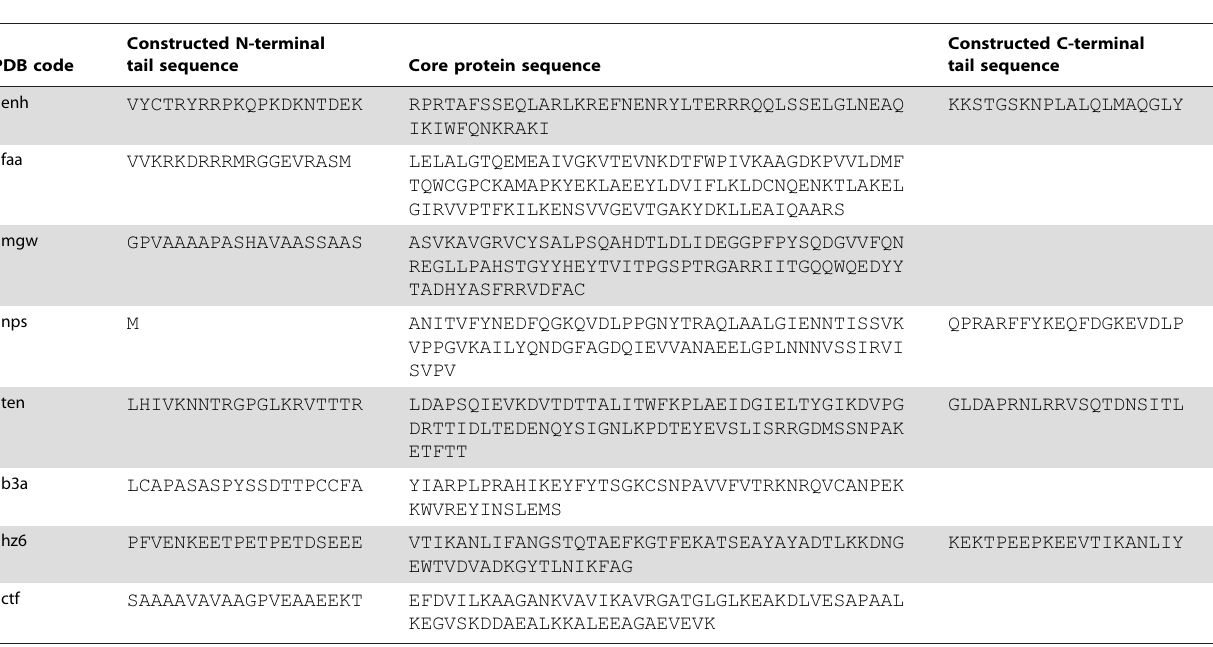
Table 1. Protein sequences used to test the prediction of disordered termini.